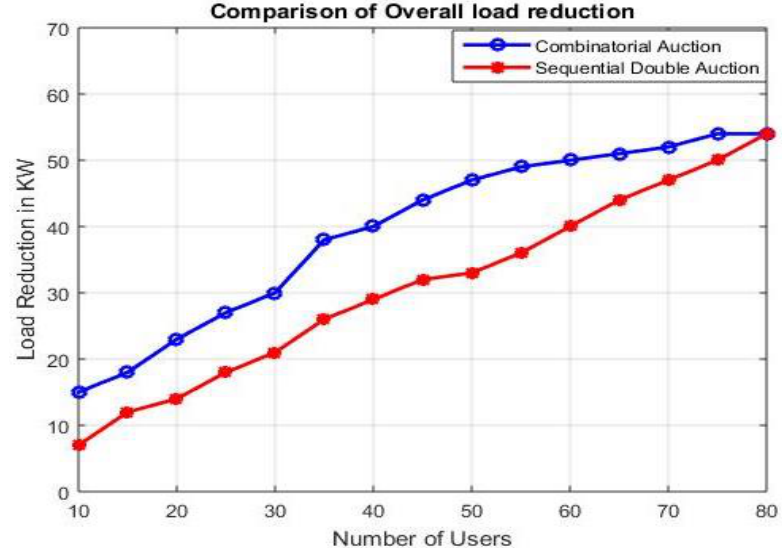
Figure 7. Overall load